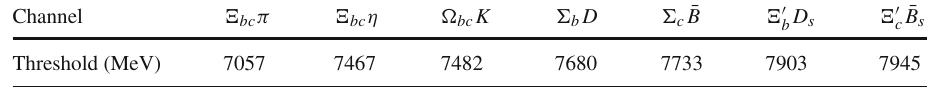
Table 4 D ij coefficients for sector J P = 1 / 2 − (MS)